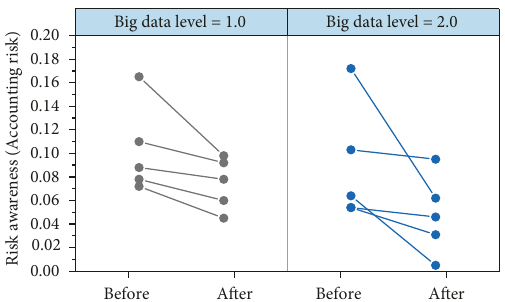
Figure 4: Relationship curve between risk awareness and ac- counting meaning ratio under different big data.